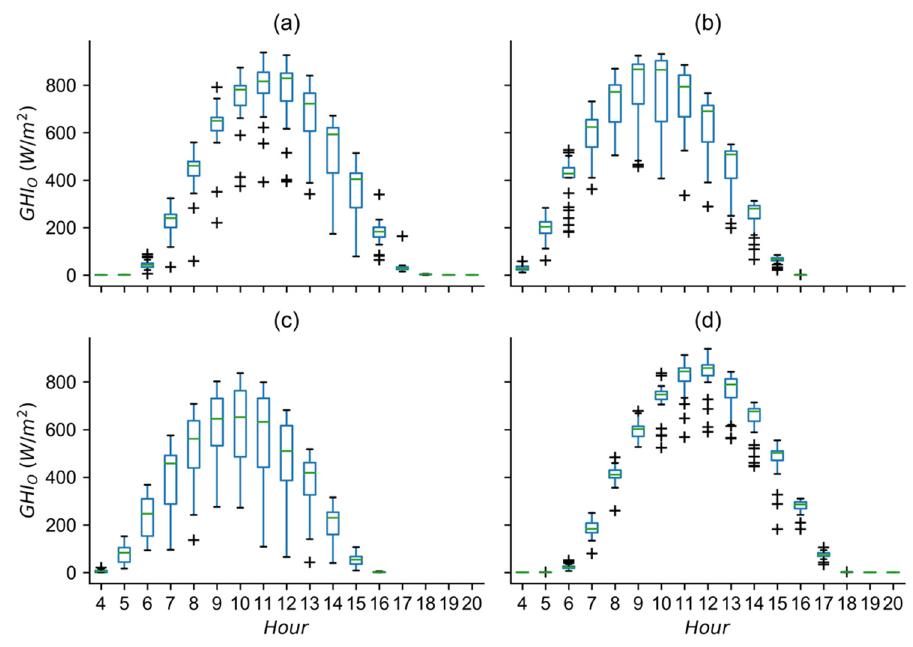
Figure 2. Hourly variation of observed GHI in the benchmarking period for: ( a ) QLD-A; ( b ) QLD-B; ( c ) VIC-A; ( d ) QLD-C. Outliers in the distribution are denoted with the “+” symbol.